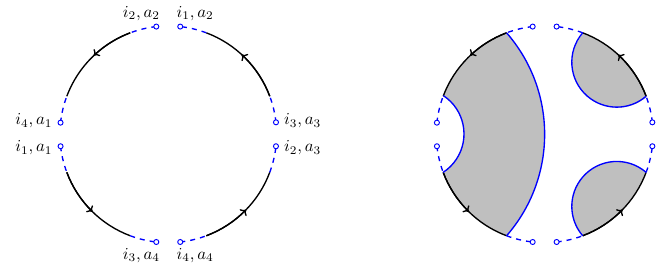
Figure 28 . Replica trick for negativity after tracing out part of the